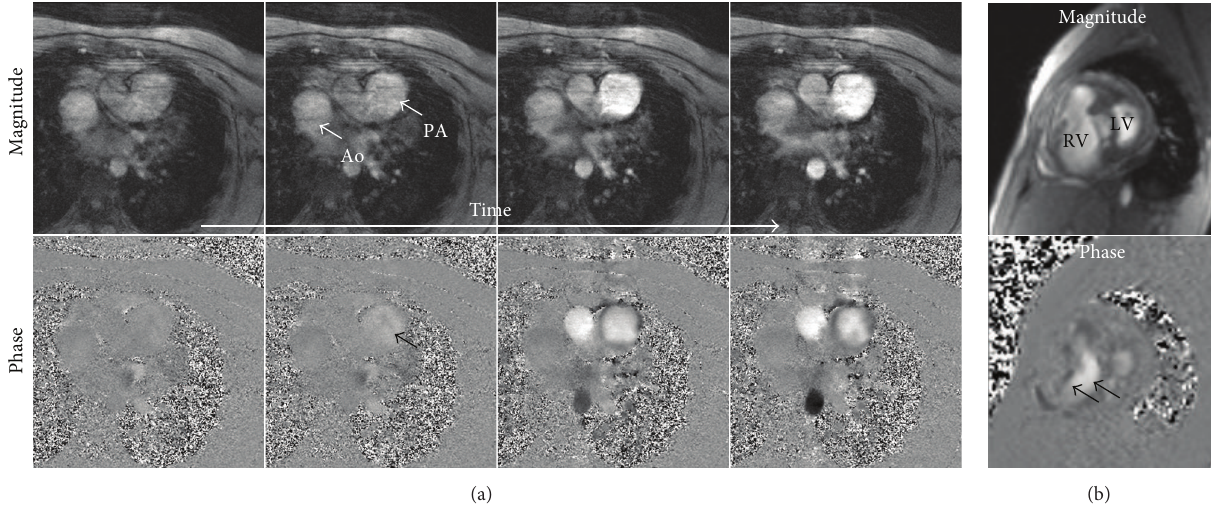
Figure 6: (a) MRI velocity-encoding magnitude (top) and phase (bottom) flow images through the main pulmonary artery at different time points during early systole. The images show a dilated pulmonary artery (PA), which appears larger than the aorta (Ao). The PA shows negligible change in cross-sectional area despite the flow increase with time (shown in the phase images). (b) MRI velocity-encoding magnitude (top) and phase (bottom) flow images through the tricuspid valve at end systole showing severe tricuspid regurgitation (arrows). LV = left ventricle; RV = right